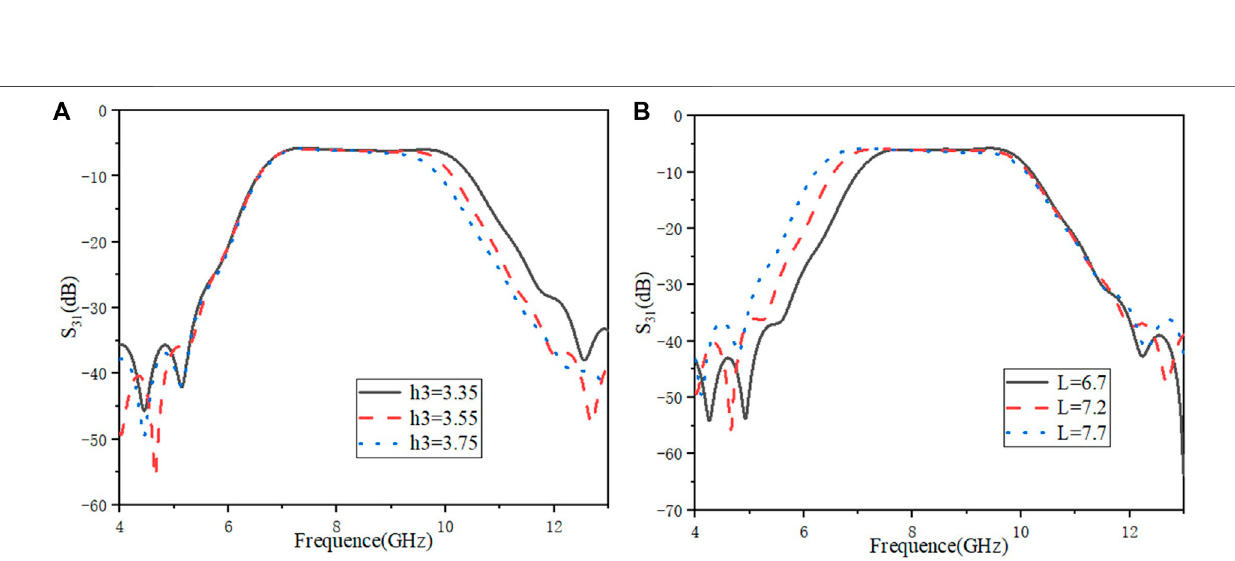
Frontiers in Physics |